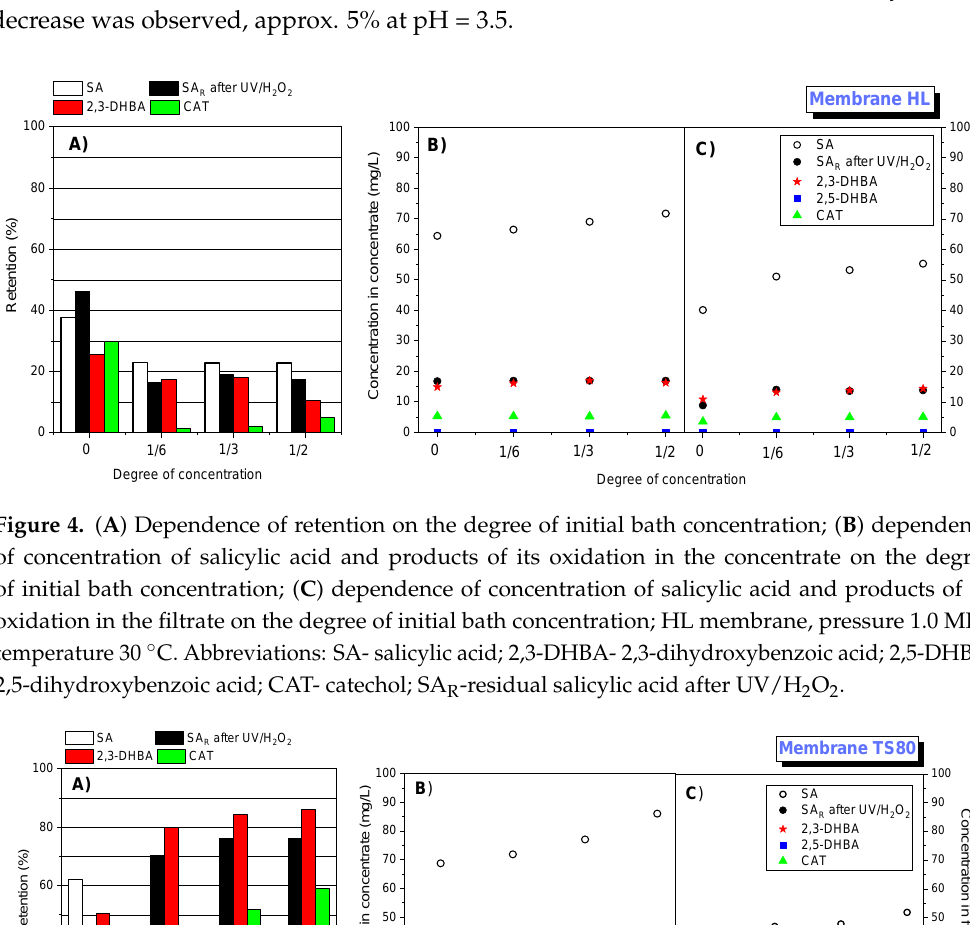
( B ) Figure 6. Dependence of filtrate flux on the filtration time: ( A ) for HL membrane; ( B ) for TS80 membrane; pressure 1.0 MPa, temperature 30 °C. ( A ) HL pure, magnification 20,000× ( B ) TS80 pure, magnification 20,000× Figure 7. SEM microscopic images of selected membranes at 20,000×: ( A ) HL pure, magnification 20,000×; ( B ) TS80 pure, magnification 20,000×.